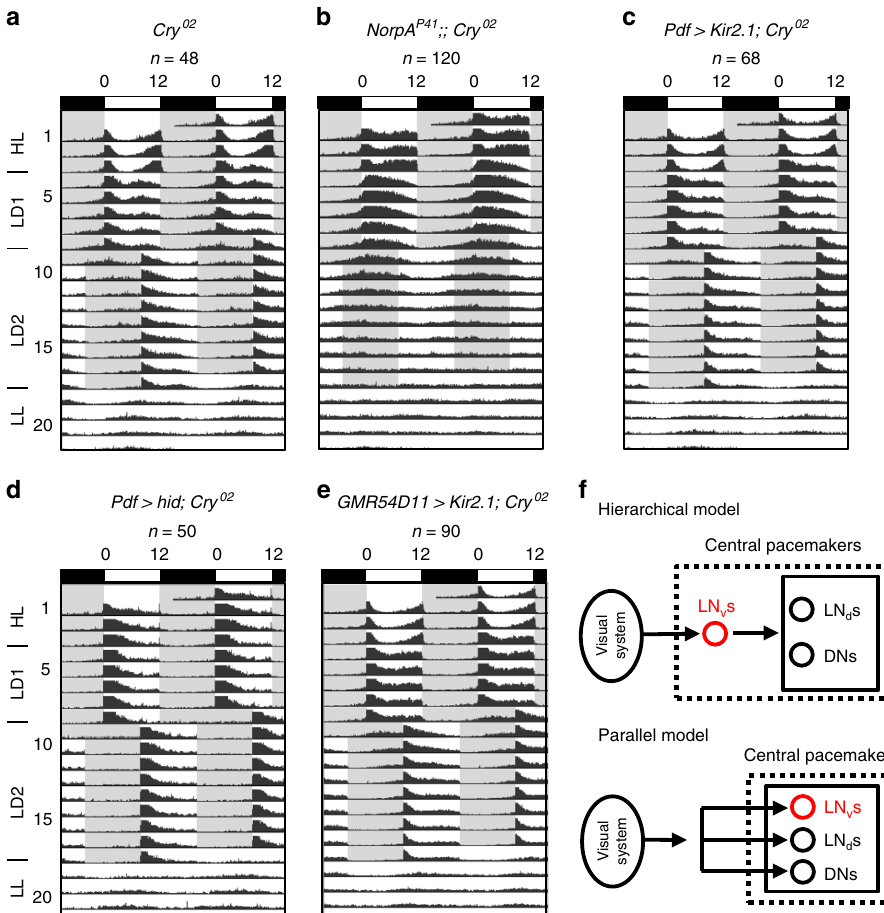
Fig. 1 Non-hierarchical photoentrainment by central pacemaker neurons. a Averaged actogram shows the Cry 02 fl ies entrain to dim LD cycles. The bars above actograms indicate light conditions: white is lights-ON and black is lights-OFF. Note the advance of evening peaks in Cry 02 fl ies after switching from the HL (~200 lux) to dim LD1 (~0.05 lux) cycles and the slow re-entrainment of evening peaks under the dim LD2 (~0.05 lux) cycles with an 8-h phase delay from LD1. n is the number of fl ies averaged in each group. b The entrainment is lost in NorpA P41 ;; Cry 02 fl ies. c Cry 02 fl ies entrain to dim LD cycles with PDF-expressing LNvs silenced by Kir2.1 . d Cry 02 fl ies entrain to dim LD cycles with PDF-expressing LNvs ablated. e Cry 02 fl ies entrain to dim LD cycles with the fi fth s-LNv and ITP-LNd silenced by Kir2.1 . f Two alternative models of the circuitry organizations of pacemaker neurons to receive visual signals for photoentrainment. Top, the hierarchical model; bottom, the non-hierarchical or parallel